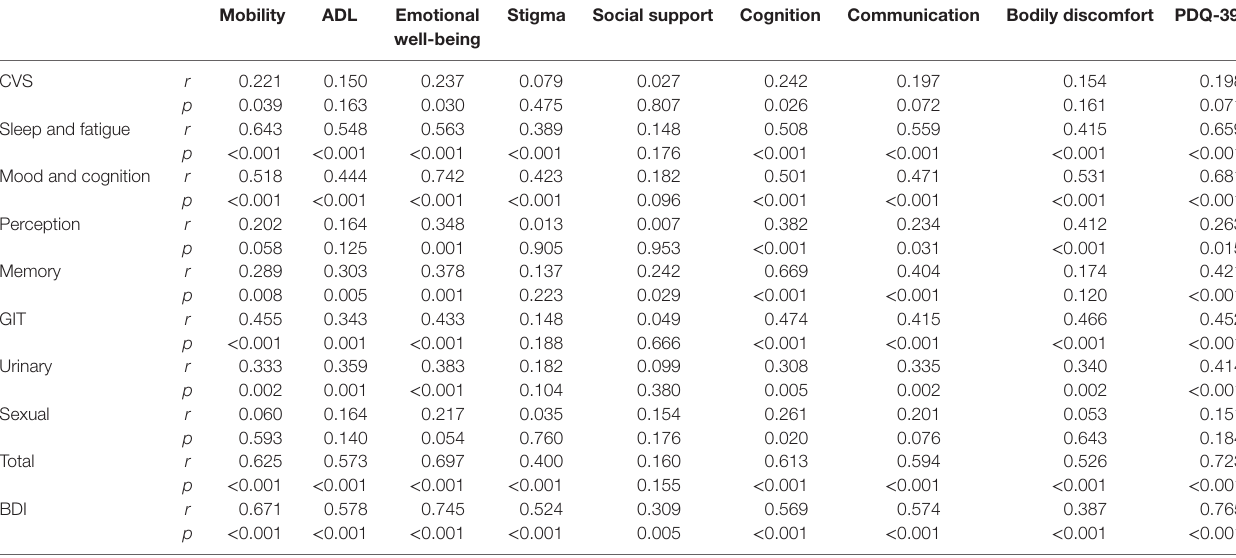
Table 4 | Correlations between NMSs and quality of life domains. Mobility aDl emotional stigma social support cognition well-being